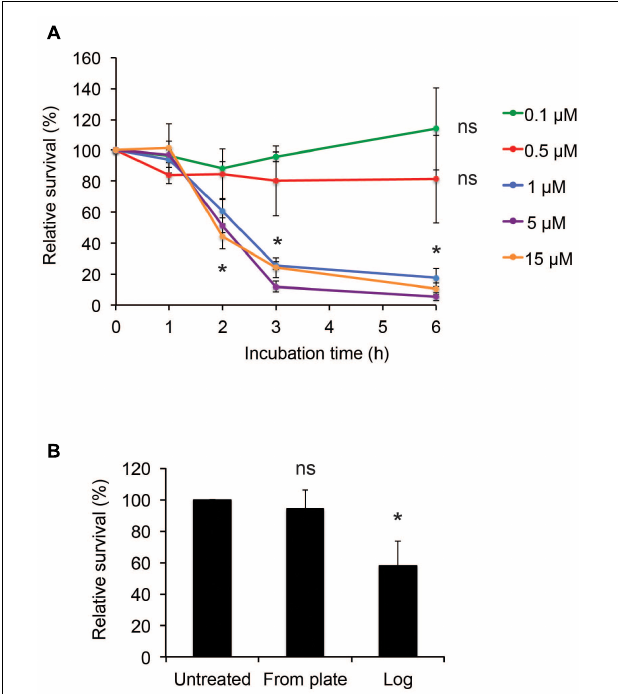
FIGURE 1 | Neisseria meningitidis is killed by hBD2. (A) Survival of log-phase bacteria incubated with hBD2 at 0.1, 0.5, 1, 5, or 15 µ M for 1, 2, 3, or 6 h. (B) Survival of bacteria, taken from 18 h over night plates directly or grown to log phase, incubated with 5 µ M hBD2 for 2 h. Viable counts were determined by plating. Survival is expressed relative to the untreated control. Data are represented as the mean survival, with error bars representing the standard deviation. Significance was tested against the untreated control. The assay was performed in triplicate three times. * P < 0.05; ns,